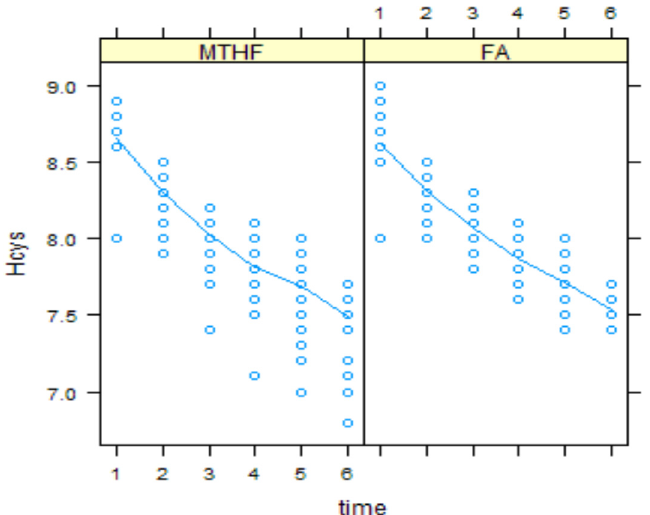
Fig 3. Serum tHcys concentration in folic acid and MTHFR groups over